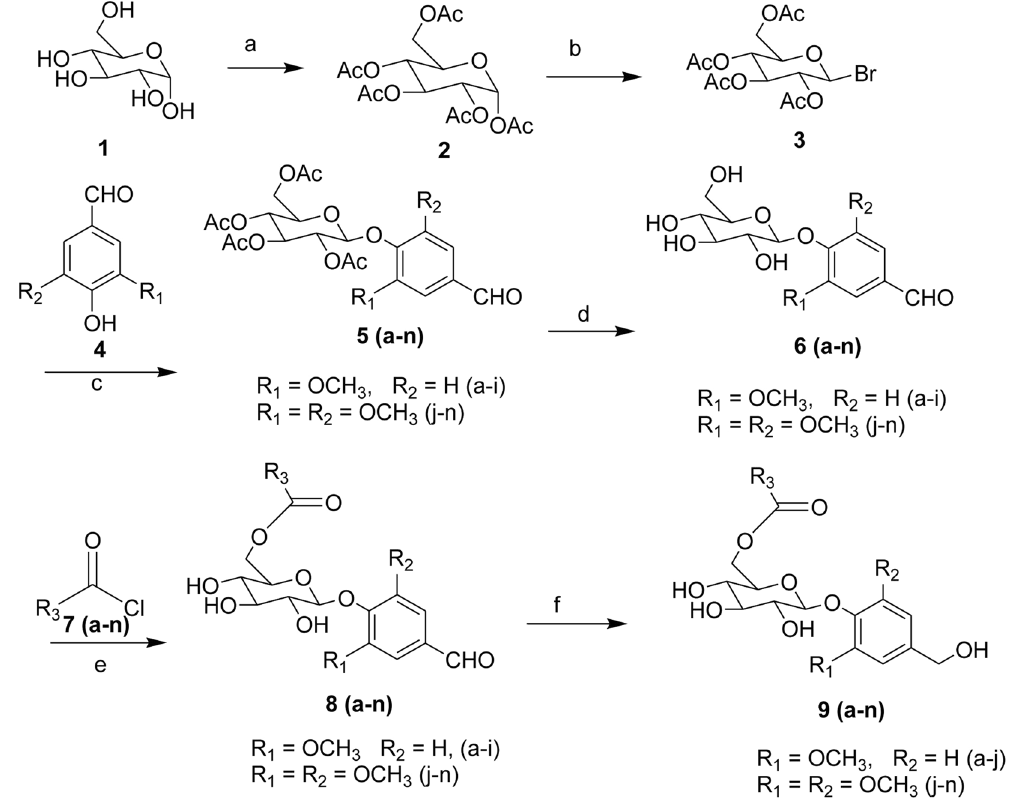
Figure 1. Synthesis of saccharumoside-B analogs. Reagents and conditions: ( a ) Ac 2 O/AcOH, HClO 4 in Ac 2 O; ( b ) HBr in glacial acetic acid; ( c ) K 2 CO 3 , DCM-H 2 O, aliquat-336; ( d ) NaOMe, MeOH; ( e ) Pyridine, DCM; ( f ) NaBH 4 , MeOH.